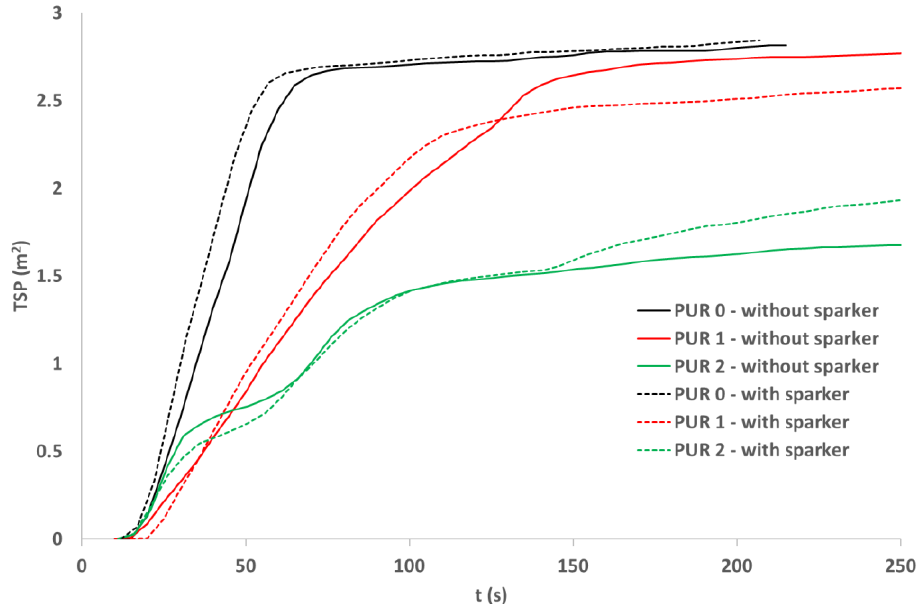
Figure 8. Total smoke production (TSP) of the PURs samples exposed to the 40 kW/m 2 of heat flux; self-ignition and spark ignition.